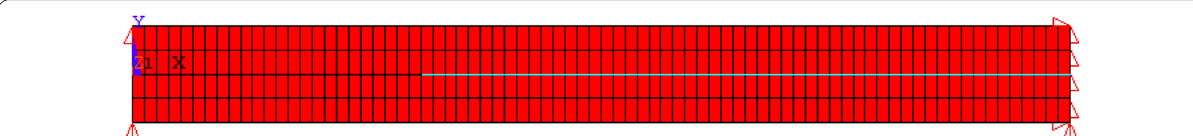
Fig. 4 Finite element mesh of double cantilever beam specimen along with boundary conditions